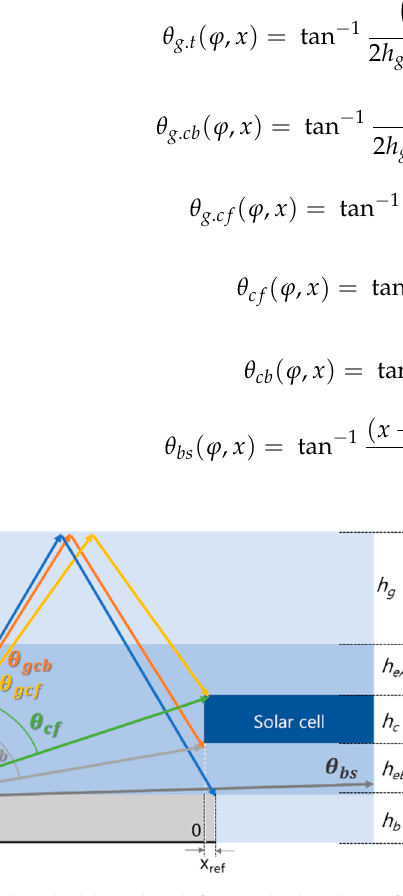
Figure 5. Threshold angles defining the borders of the different ray groups. Table 1. Definition of ray groups by reflectance angle and surface that is hit by the rays in this